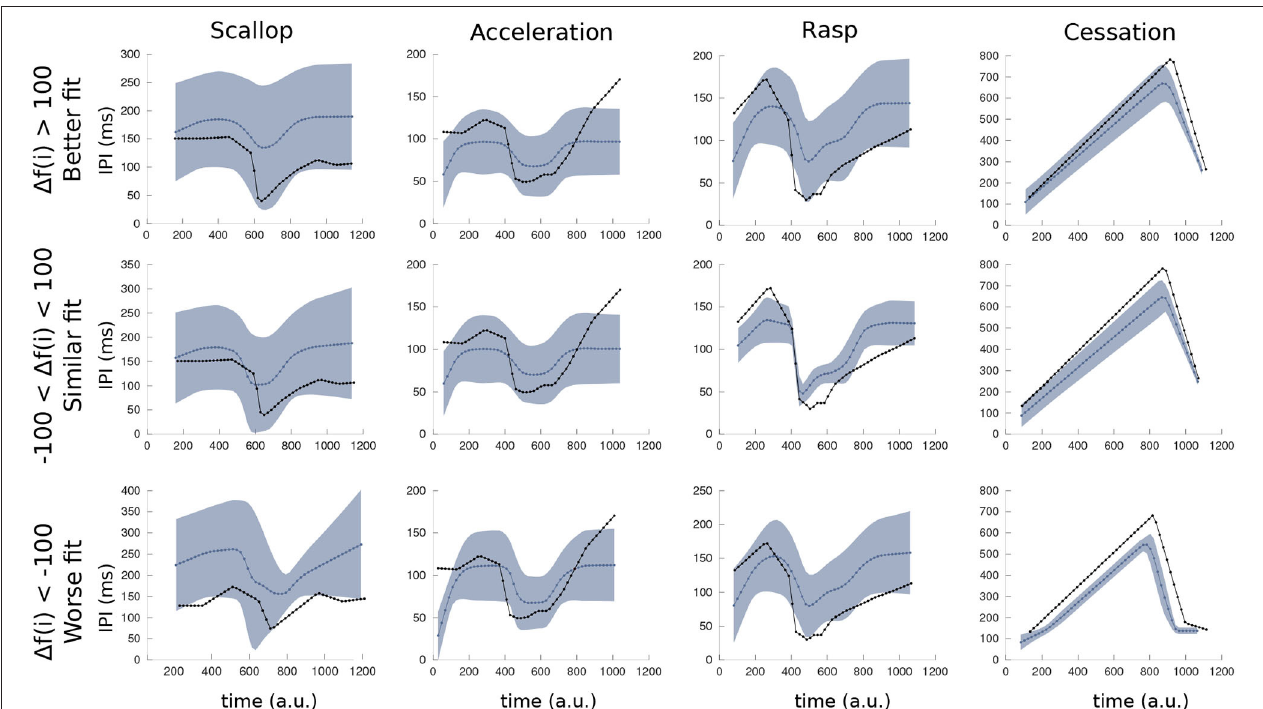
FIGURE 6 | Mean and variance of simulated SPIs using the R-GA model under the variated simulation conditions of the robustness analysis (refer to Figure 5 ). As in the GA fitness function, the duration of each simulation was normalized to 1,000 arbitrary units for representation, starting at its first IPI. The blue line is the mean SPI from the executions with variated inputs, blue shade represents the SD. Finally, the SPI represented in black is the closest target pattern. Simulations of each SPI pattern were divided into three partitions (with a similar number of elements) according to its fitting value: the ones that obtain better fitting (upper row: 1 f < − 100), those that obtain similar results to the reference fitness value (center row: − 100 < 1 f < 100) and the ones that yield worse fitting results (bottom row: 100 < 1 f ).